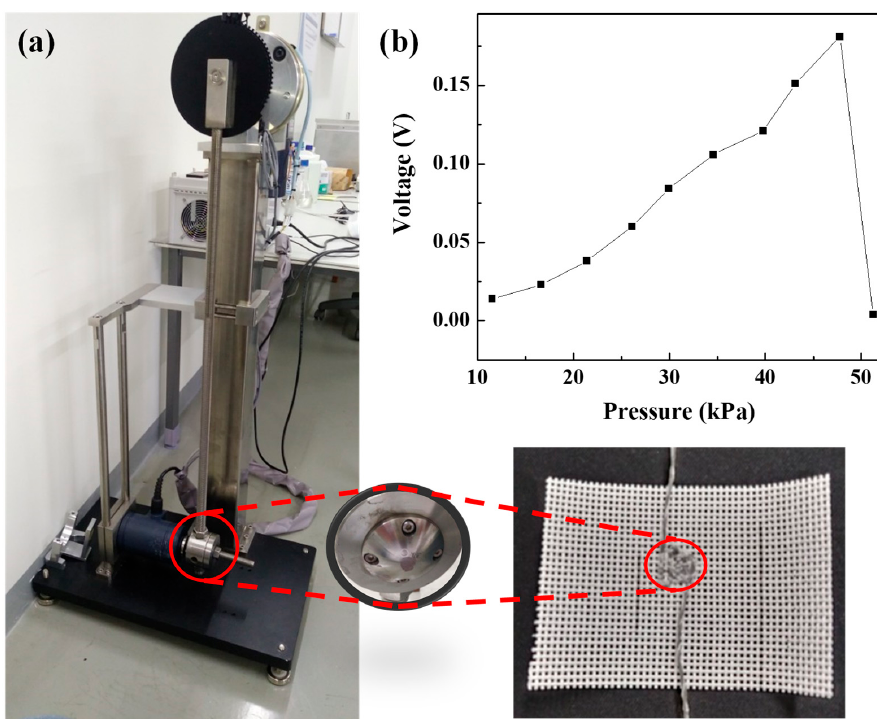
Figure 3. ( a ) Equipment used to apply constant pressure to a piezoelectric energy harvester module stitched with a width of 0.7 cm 2 and interval of 0.15 cm by the core-shell piezoelectric yarns, and ( b ) output voltage according to the applied pressure.